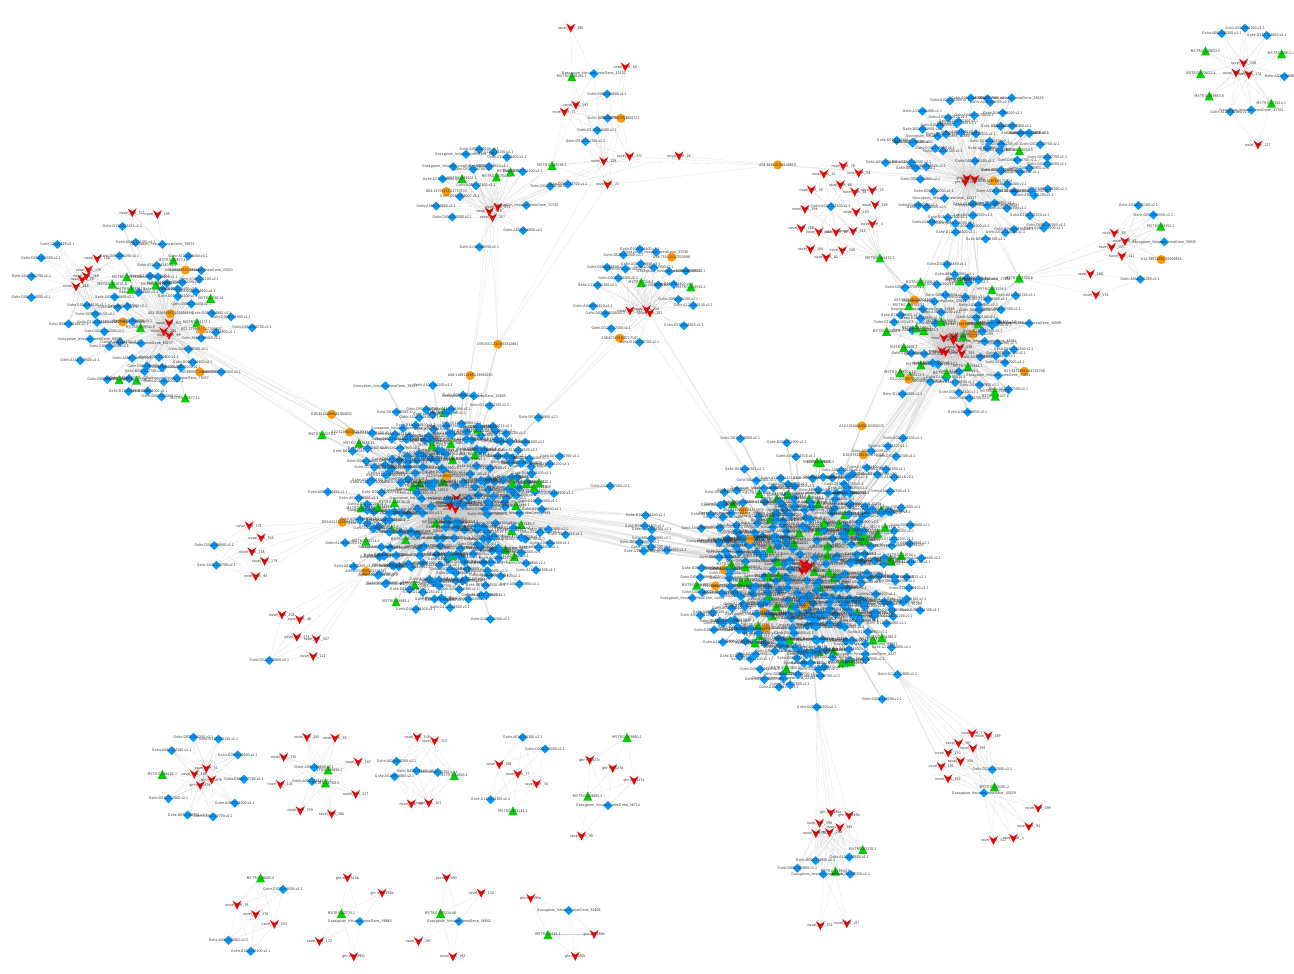
Figure 9. ceRNA regulation network. Note: circRNA: orange circles. Gene: blue diamonds. lncRNA: green triangles. miRNA: red